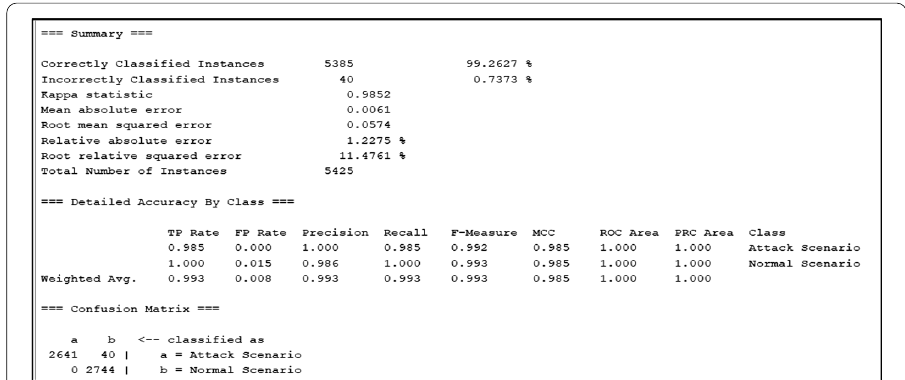
Fig. 7 Detailed Accuracy for Test Dataset using Naive Bayes Machine Learning Algorithm